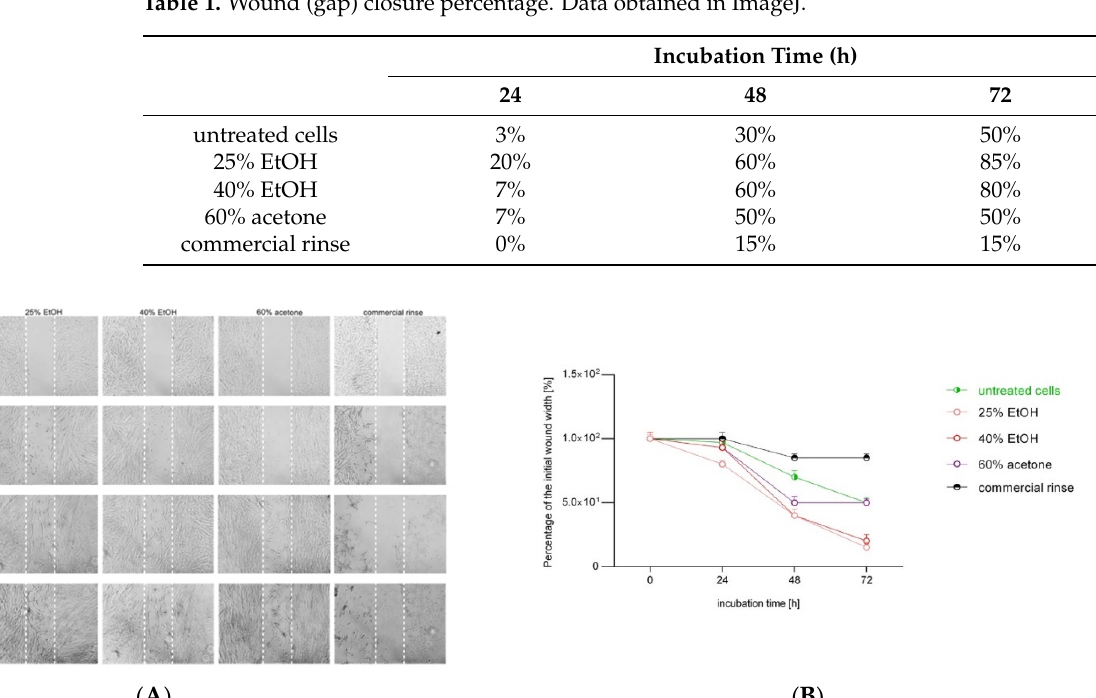
Figure 4. Effect of different extracts of Reynoutria japonica (at 50 µg/mL) and commercial dental rinse (1.56% solution) on fibroblast motility investigated with wound healing assay. Note that 25% EtOH, 40% EtOH, and 60% acetone means 25% ethanol extract, 40% ethanol extract, or 60% acetone extract from Reynoutria japonica rhizomes, respectively. ( A ) Images of wound gradually invaded by migrating cells; ( B ) The percentage of a healed wound as a function of time. Images were analyzed by ImageJ software; images were taken in given time intervals. The graph represents the data form the three replicates of an individual experiment. Data are mean ± SD ( n = 3 replicates).